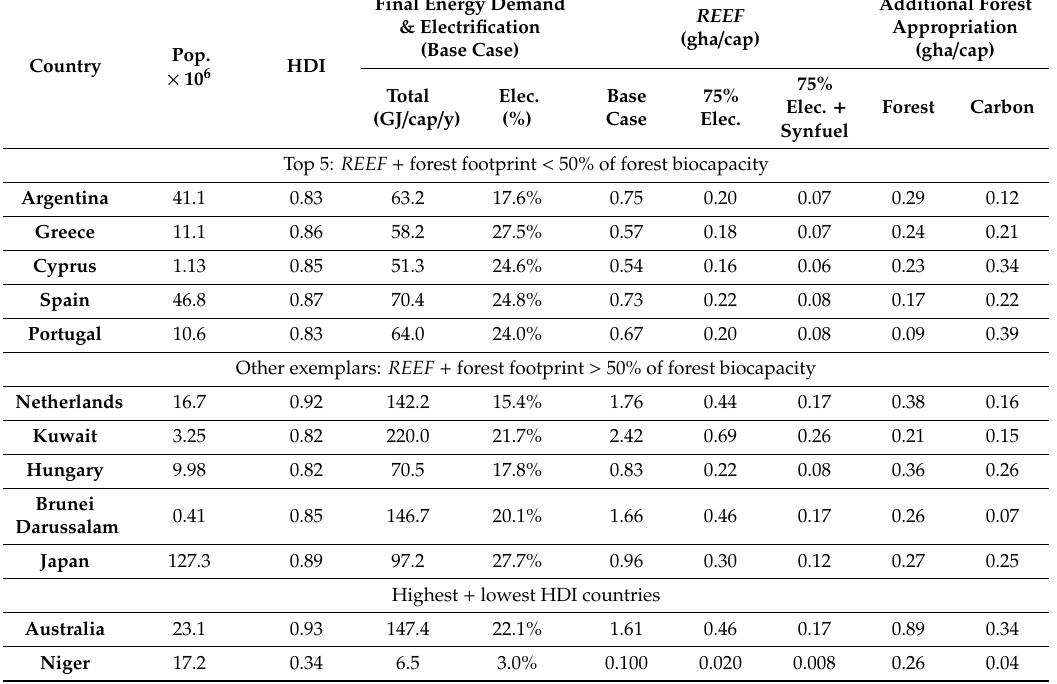
Table 5. Energy consumption patterns for exemplar and non-exemplar countries.